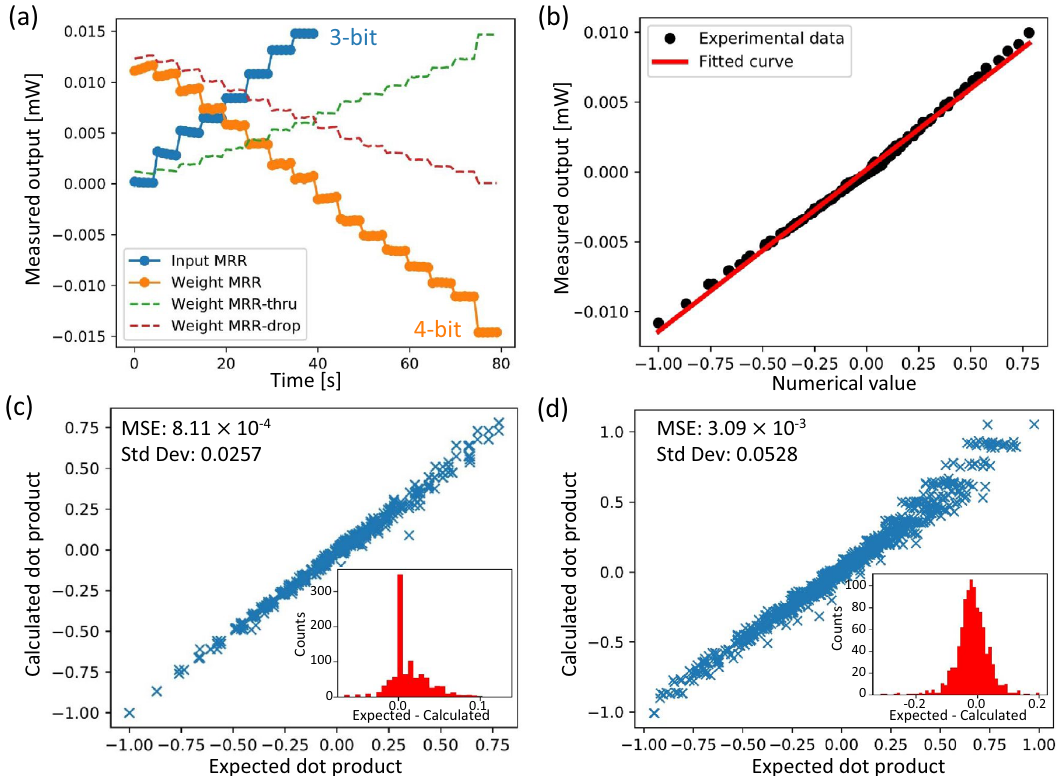
Figure 9. ( a ) Measured power levels of the proposed IM-MRM-based co-packaged chip. The blue steps represent the power level of the all-pass IM-MRM, and the orange steps represent the differential power level of the add-drop IM-MRM after the subtraction between drop and through ports. ( b ) Experimental look-up table for the co-packaged chip using point-to-point mapping scheme with a first-order linear fitting. ( c ) Calculation accuracy for dot product operations with 1000 random digital numbers which are selected from power levels. Inset: The histogram of the Gaussian distribution of the errors. ( d ) Calculation accuracy for dot product operations with 1000 random decimal floating-point numbers rounded to the closest power level. Inset: The histogram of the Gaussian distribution of the